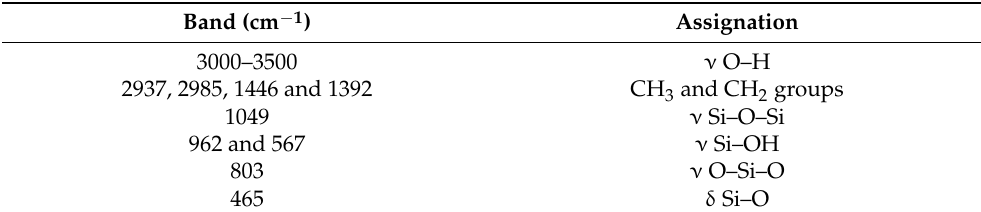
Table 1. Characteristic absorption bands of SiO 2 .